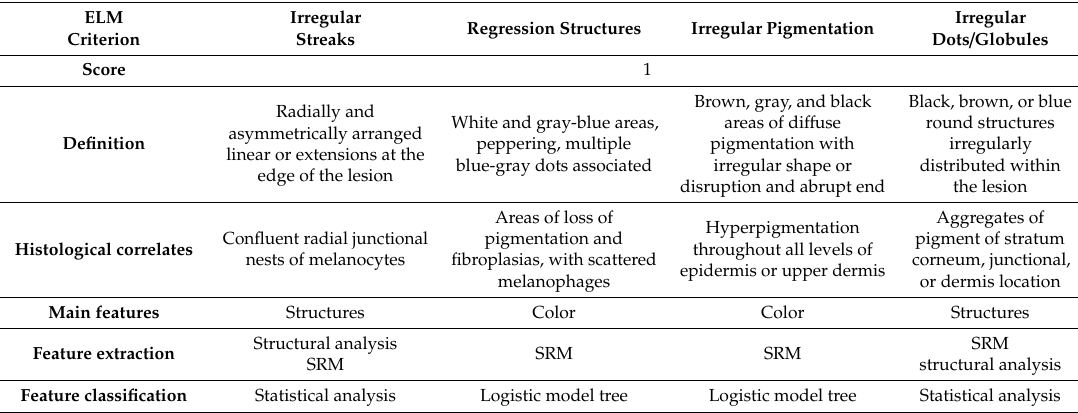
Table 2. The automatic system based on Seven-Point Checklist: Definition and detection methods of minor dermoscopic criteria.